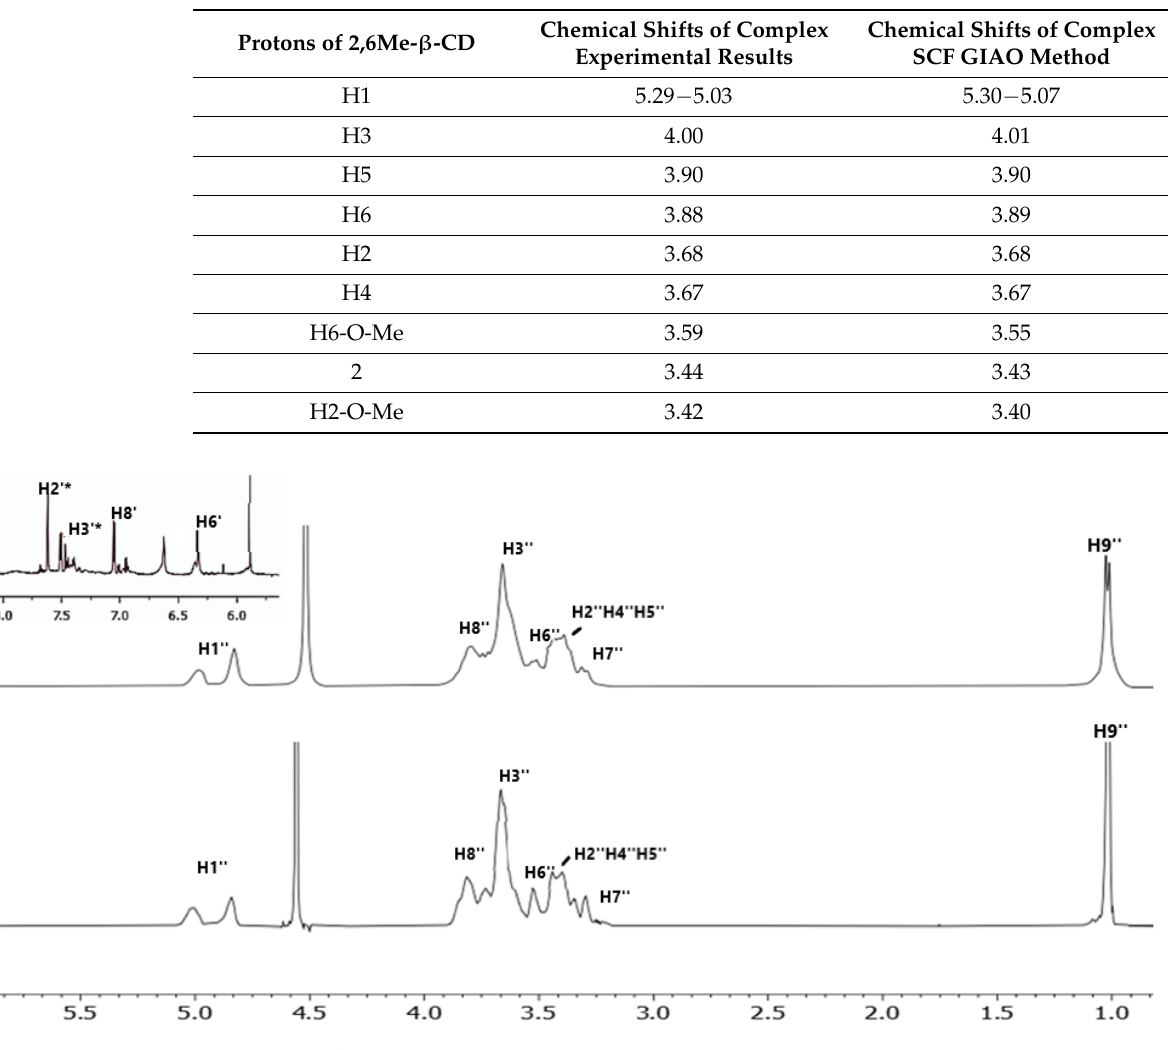
Table 2. 1 H NMR chemical shifts using the SCF GIAO method and experimental results for the 2,6Me- β -CD in the complex.